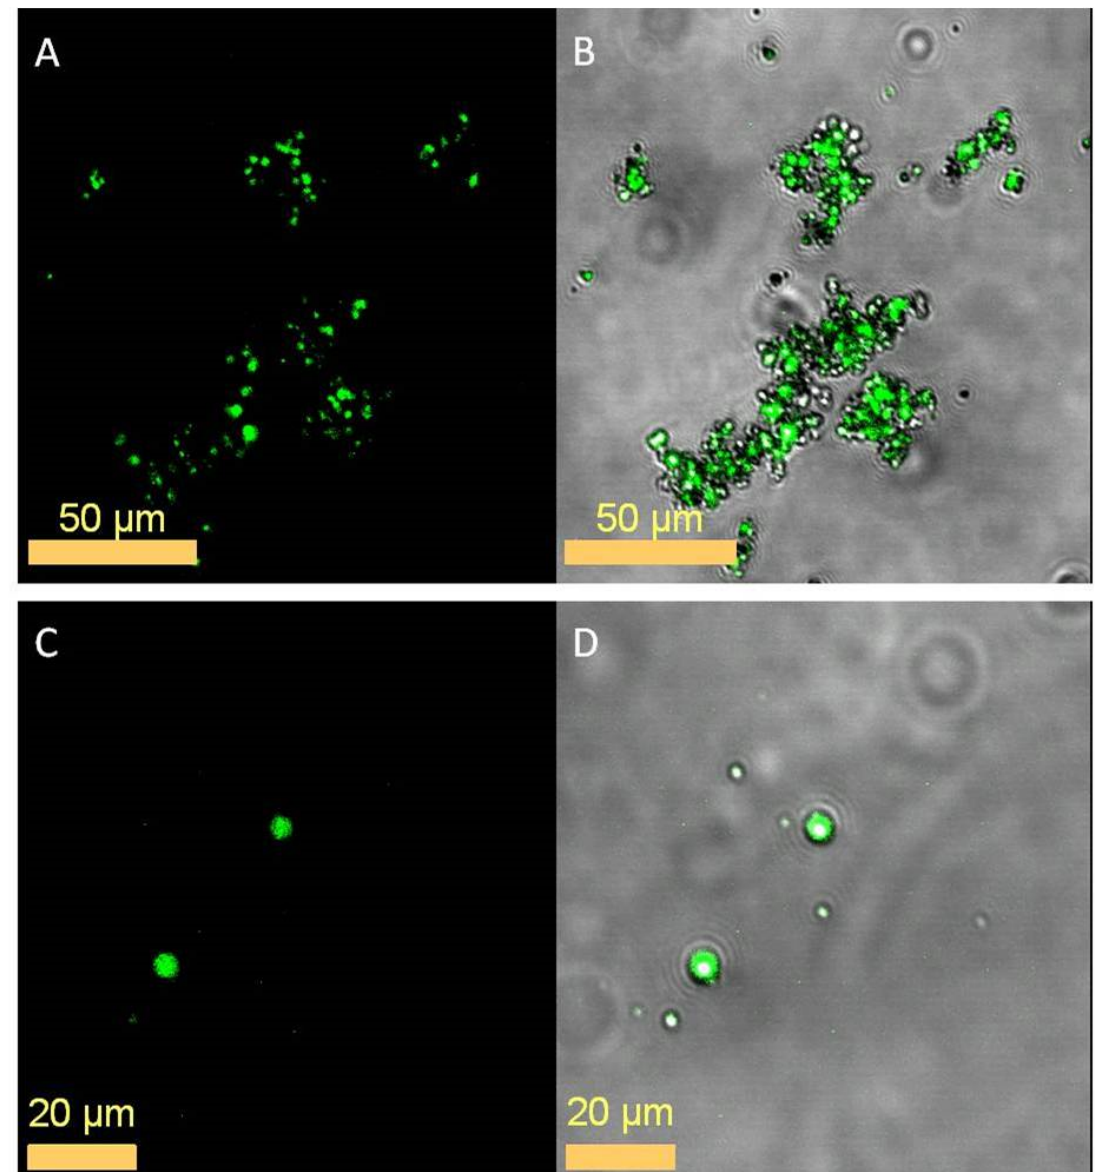
Figure 7. Confocal fluorescence microscopy of microcapsules from CaCO 3 -coated emulsion droplets with Nile-Red fluorescent dye entrapped within the oily interior of the emulsion. Confocal fluorescence images are shown to the left ( A , C ), while the right images ( B , D ) show an overlay with the bright-field images. The high intensity of the fluorescence suggests that the entrapment of the active agent was very successful, as seen in both a large collection of particles in ( A ), as well as in individual microcapsules shown at higher magnification in ( C ). The fluorescence corresponds to the interior of the microcapsules for the cluster ( B ) and the individual microcapsules ( D ) when overlapped with their respective bright-field images.